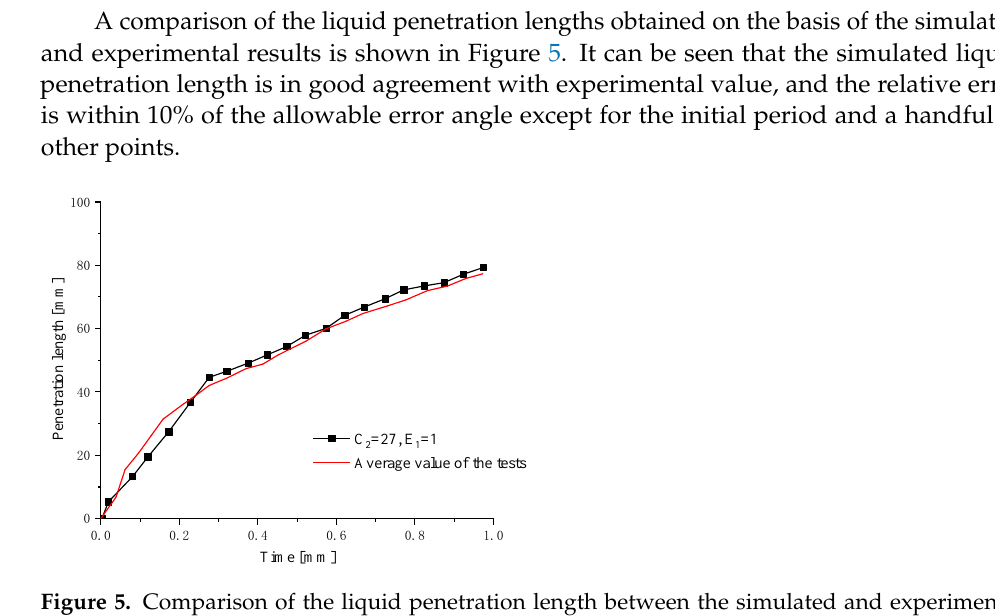
Figure 5. Comparison of the liquid penetration length between the simulated and experimental results for Case 1.